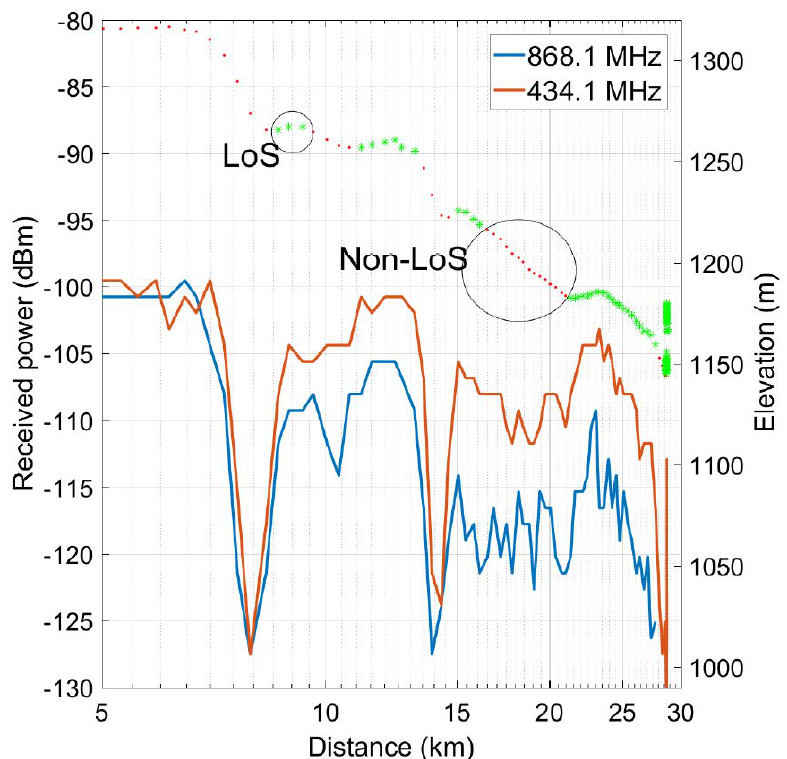
Figure 9. SNR as a function of distance. LoS: Line-of-Sight; NLoS: